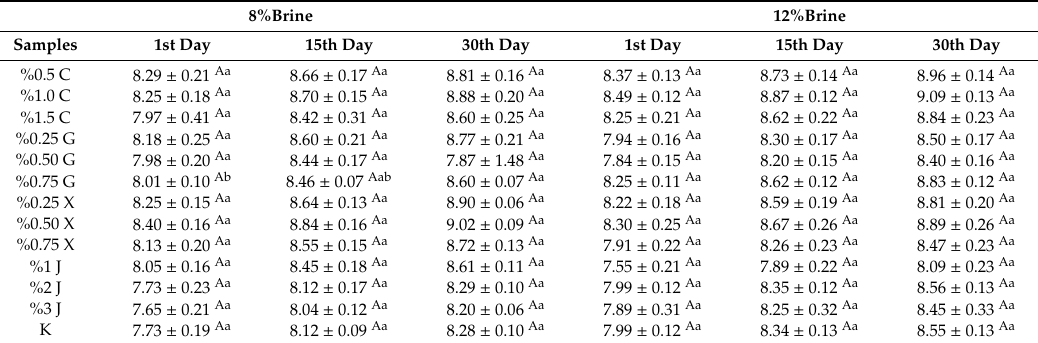
Table 5. LAB count (log CFU / g) of cheese samples during storage.